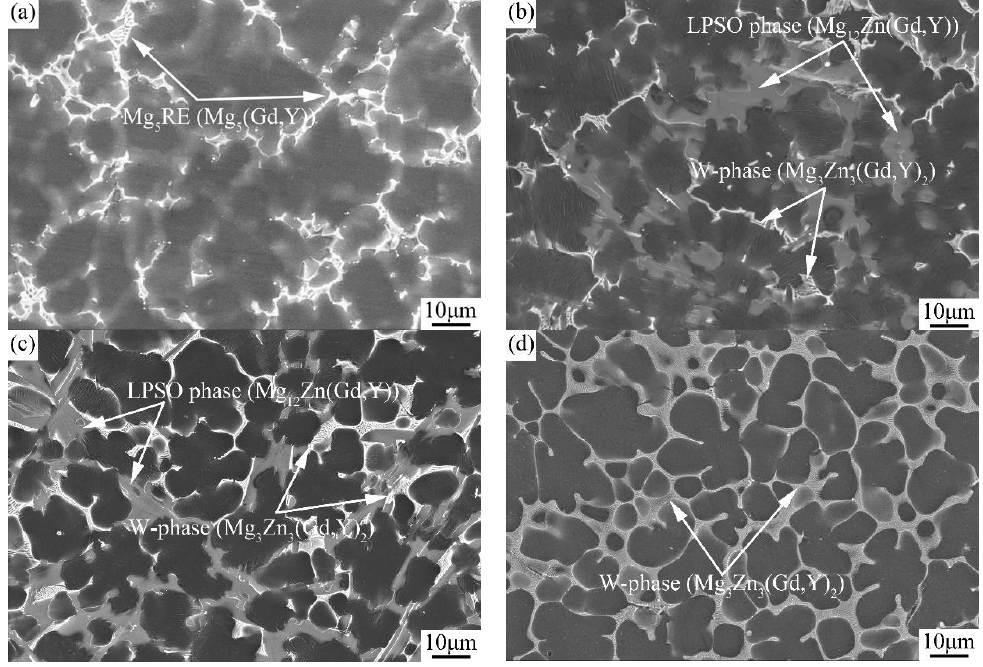
Figure 4. Microstructure and morphology of Mg–7Gd–5Y– x Zn–0.5Zr alloys: ( a ) x = 0 wt%; ( b ) x = 3 wt%; ( c ) x = 5 wt%; ( d ) x = 7 wt%.